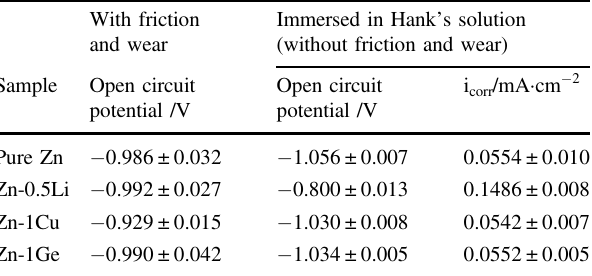
Table 2 Electrochemical data of pure Zn, Zn-0.5Li, Zn-1Cu and Zn-1Ge. With friction Immersed in Hank ’ s solution and wear